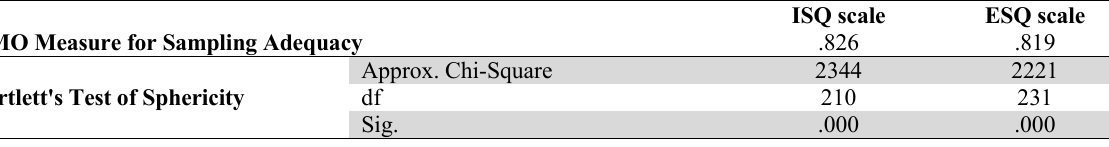
KMO and Bartlett's Test of Sphericity KMO Measure for Sampling